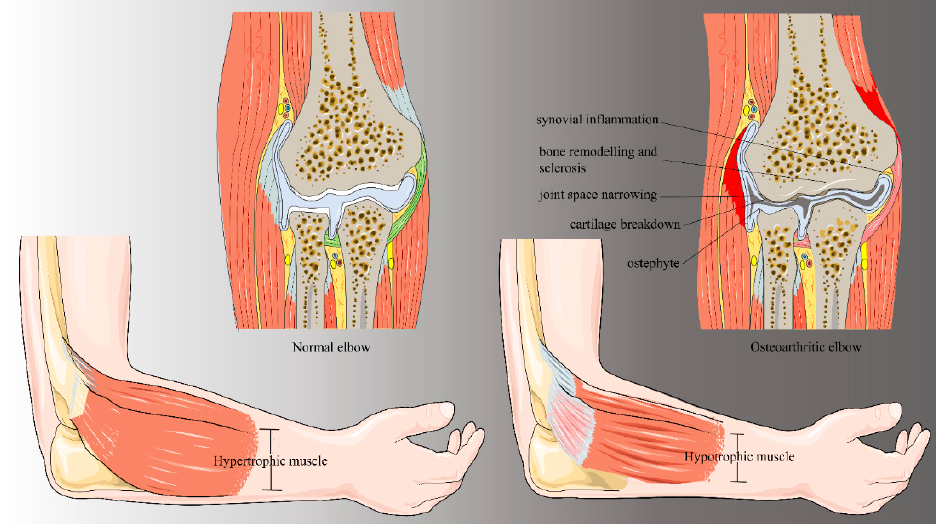
ff erences between normal and osteoarthritic Figure 1. Differences between normal and osteoarthritic elbow. Figure 1. Di